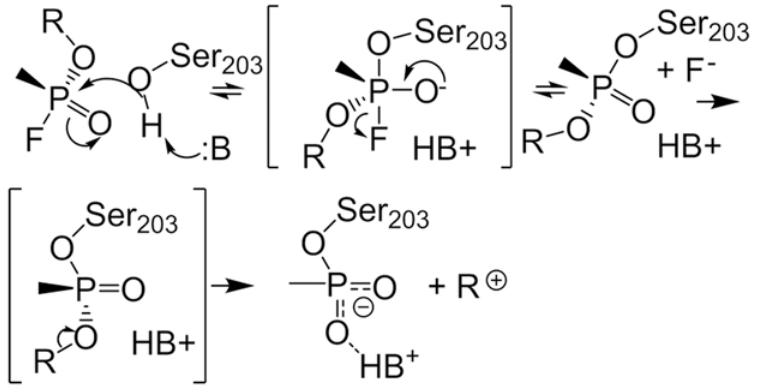
Fig 2. Mechanisms of soman phosphonylation and subsequent ageing of hAChE. The nucleophilic attack of the deprotonated Ser203 hydroxyl group on the phosphorous atom of soman. The leaving group is the fluoride ion. Ageing is shown as the cleavage of the pinacolyl R-group from the phosphorous